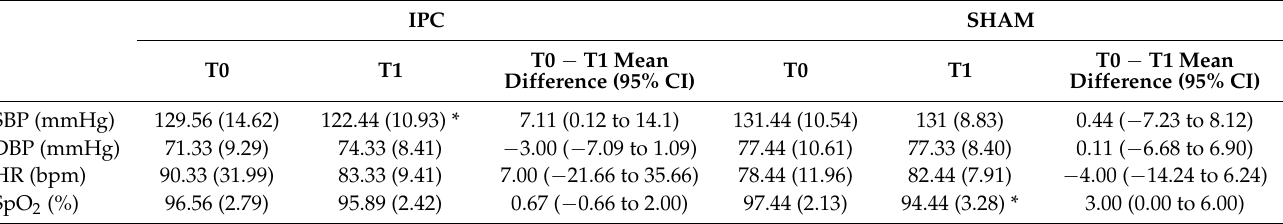
Table 1. Cardiovascular parameters before and after the interventions.